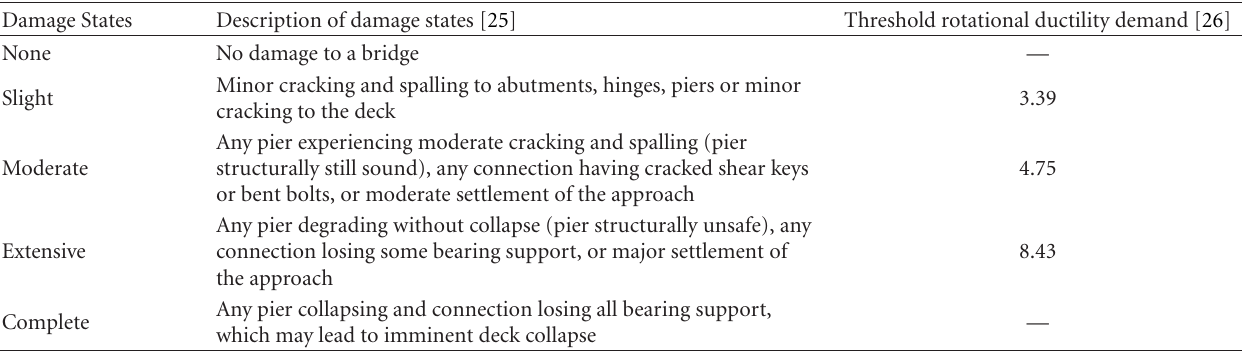
Table 2: Damage states and threshold rotational ductility demands for the bridge piers.